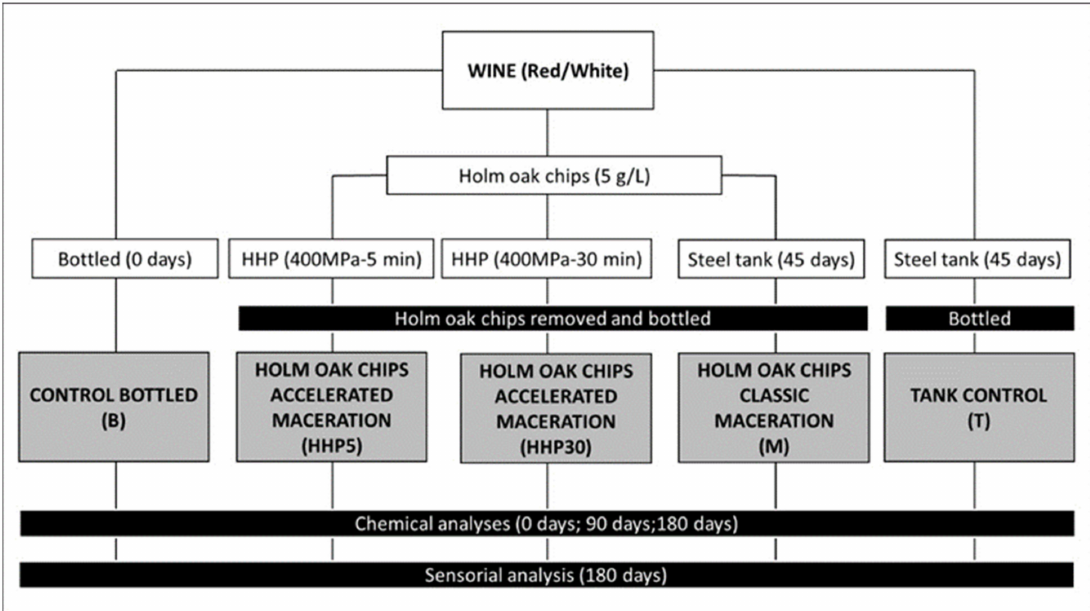
Figure 1. Experimental